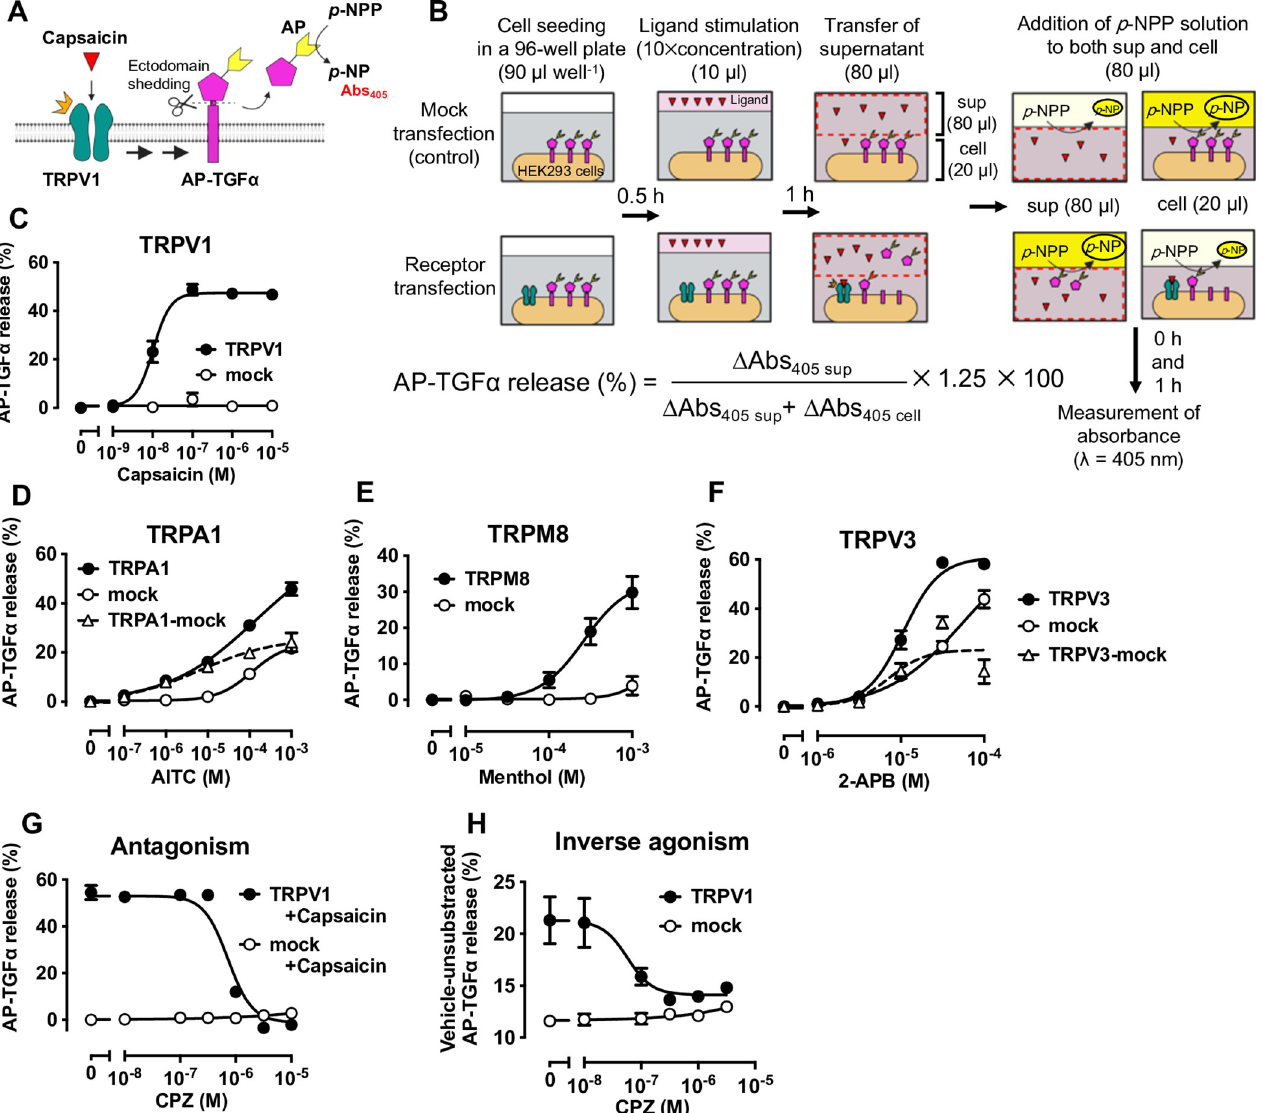
Fig 1. TGF α -shedding assay can evaluate TRP channel activation. (A) Schematic representation of the TGF α -shedding assay for detecting transient receptor potential (TRP) channel activation. TRPV1 is activated upon capsaicin stimulation, inducing AP-TGF α ectodomain shedding. Released AP-TGF α can be quantified by measuring AP activity in the supernatant based on the production of para-nitrophenol ( p -NP) from para-nitrophenyl phosphate ( p -NPP). (B) Schematic of the assay protocol: HEK293 cells transiently expressing AP-TGF α with or without TRP channel expression are reseeded onto 96-well plates and stimulated with a ligand. After the supernatant (sup) is transferred to a blank plate, AP-TGF α release is quantified by a colorimetric reaction to measure AP activity, using p -NPP as a substrate. AP-TGF α release (%) is calculated as the ratio of AP activity in the supernatant to the total AP activity. Δ Abs 405 was calculated by subtracting the absorbance at 405 nm measured at 0 h [Abs 405 (0 h) ] from the absorbance at 405 nm measured at 1 h [Abs 405 (1 h) ], using 1.25 as a correction factor for the amount of supernatant transferred (80 of 100 μ L). See Methods for details. (C) Concentration–response curve for the TGF α -shedding responses induced by TRPV1 activation upon capsaicin stimulation. The vehicle-treated condition is set as the baseline. Mock-transfected cells expressing only the AP-TGF α reporter were used as a control. (D–F) Concentration–response curves for the TGF α -shedding responses induced by TRPA1 (C), TRPM8 (D), and TRPV3 (E) activation upon AITC, menthol, and 2-APB stimulation, respectively. (G, H) Evaluation of antagonist activity (G) and inverse agonist activity (H) for capsazepine (CPZ). CPZ antagonism was examined in the presence of 100 nM capsaicin. Note that inverse agonism is shown without subtracting the vehicle-treated basal responses. In all panels, the symbols and error bars represent the mean and SEM, respectively, for three independent experiments performed in triplicate. For many data points, the vertical error bars are smaller than the symbols and, thus, are not visible.